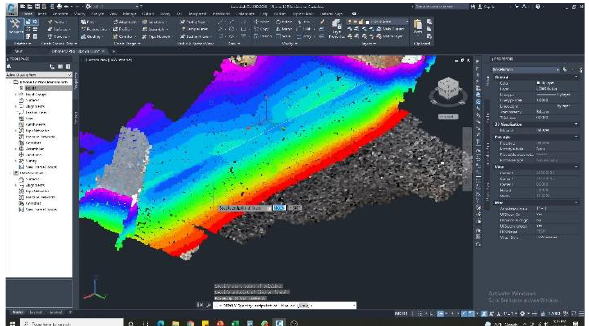
Image 1. The point cloud alignment to points measured with the Total